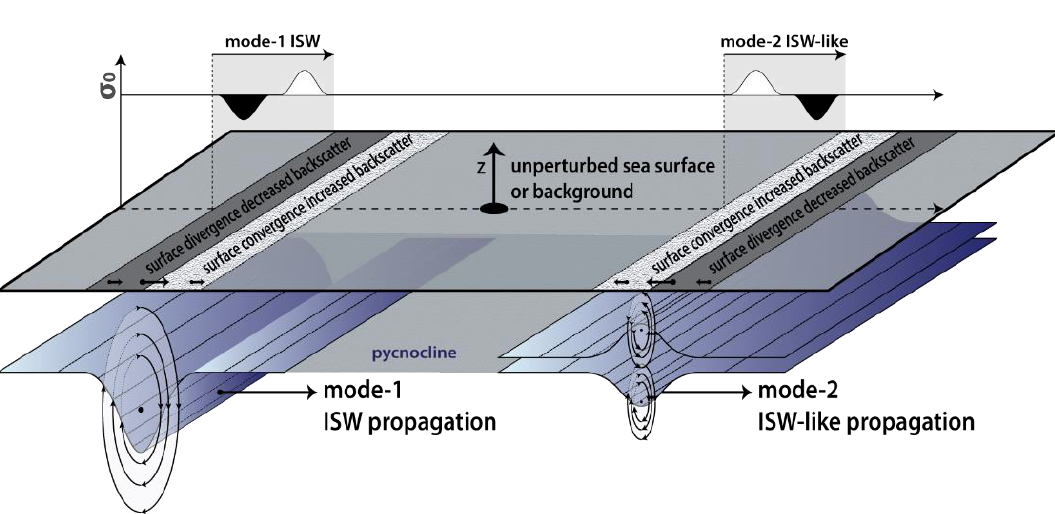
Figure 2. Schematic representation of Internal Solitary Wave (ISW) sea surface manifestations in Synthetic Aperture Radar (SAR) images with respect to an unperturbed background. A comparison between the mode-1 ( left ) and mode-2 ( right ) vertical structures is illustrated for waves propagating rightwards along the ocean pycnocline. From top to bottom, a measure for σ o is seen to depart from the background owing to the convergence and divergence patterns induced by the waves’ surface currents—all of which reverse between mode-1 and mode-2 waves.